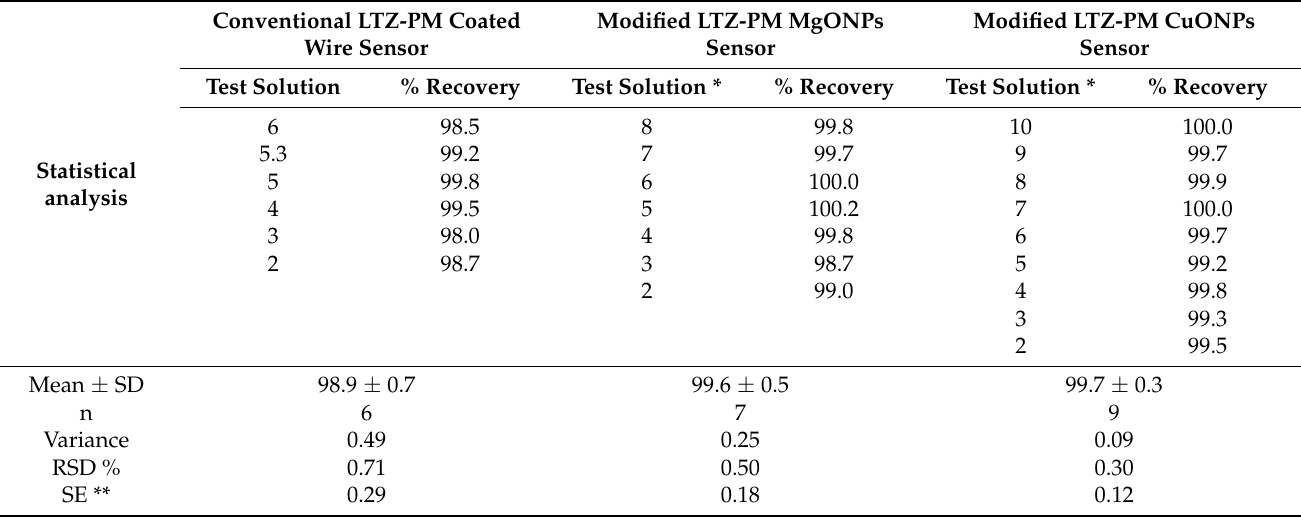
Table 3. The outcomes from the determination of LTZ in pure form using fabricated LTZ-PM, modified LTZ-PM-MgONPs and LTZ-PM-CuONPs coated wire sensors.